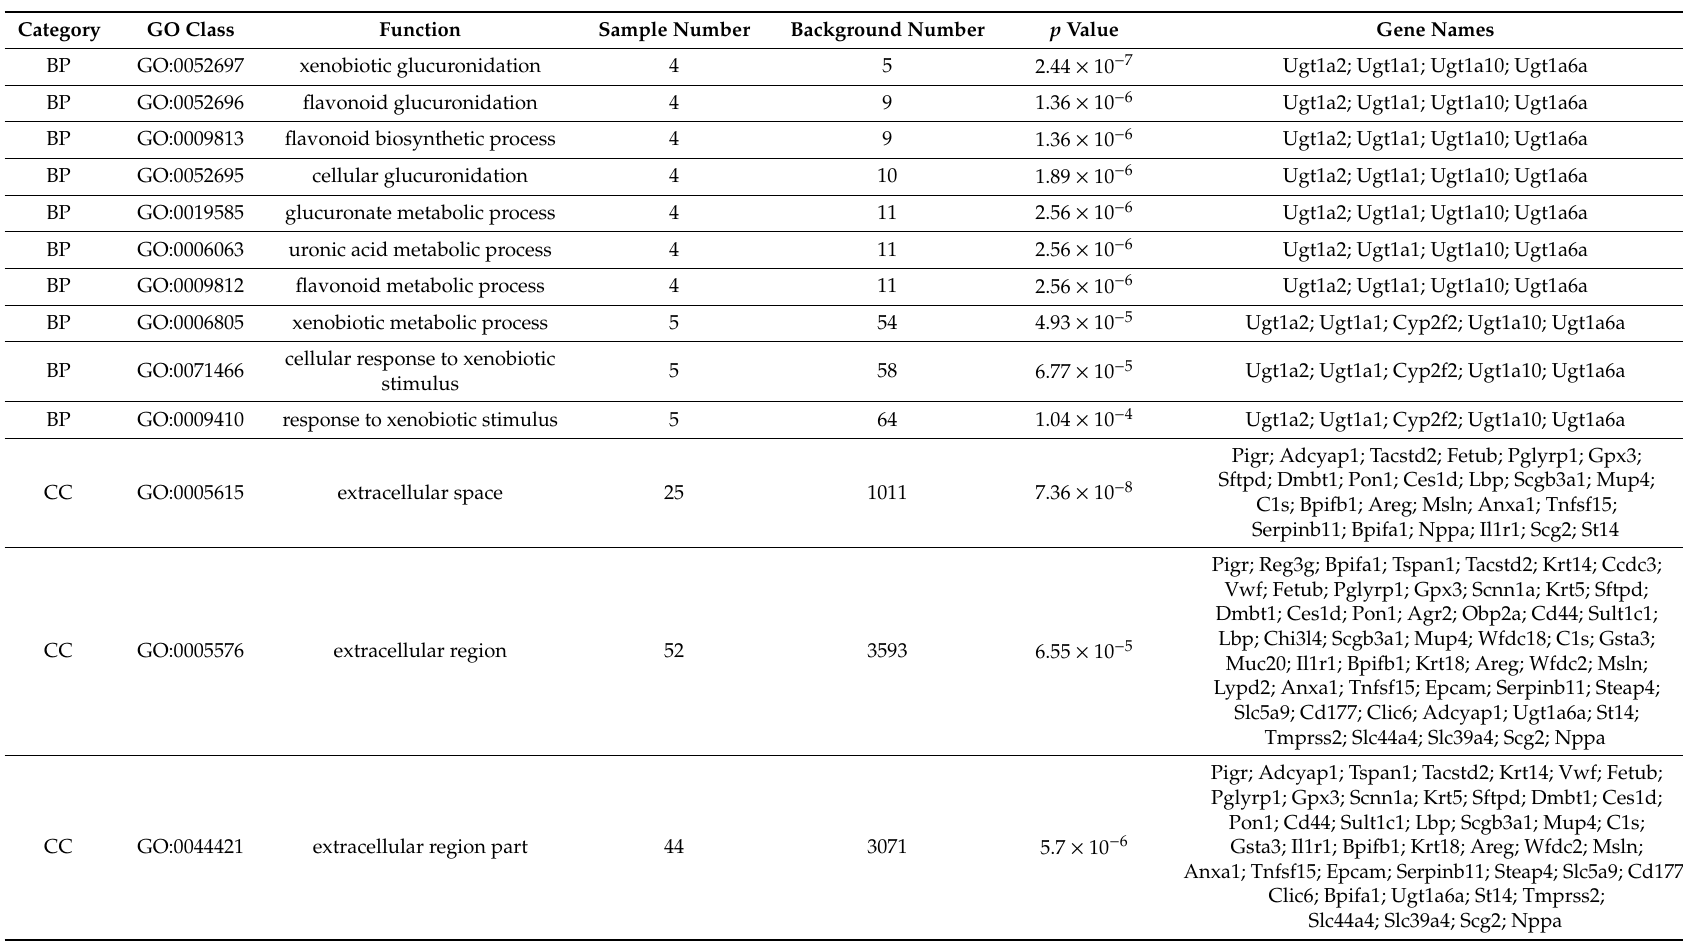
Table 1. A list of the Gene Ontology identifiers in the cluster of overlapping di ff erentially expressed genes in Se-Met-treated AD mice compared to control AD